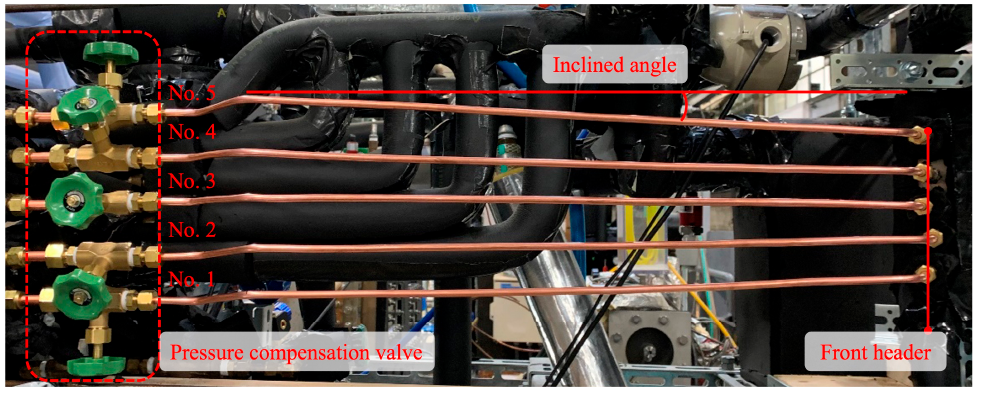
Figure 3. Example of the installation of a 120 mm header.